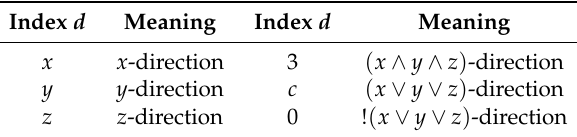
Table 2. Investigated percolation directions d . With index d = { x , y , z } the corresponding space directions are indicated. Index d = 3 represent percolation in all directions at the same time, d = c at least one direction, and d = 0 stands for no percolation at